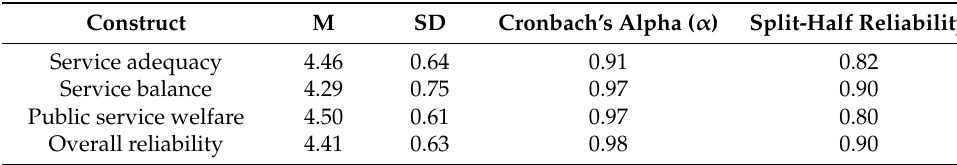
Table 3. Item means, standard deviations, and reliability of PEESQ.